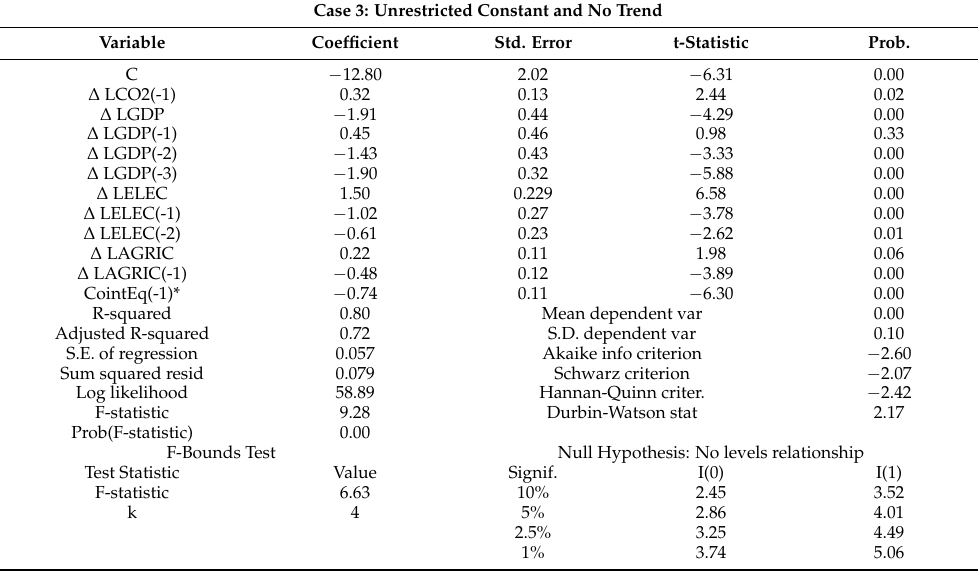
Table 3. ARDL error correction